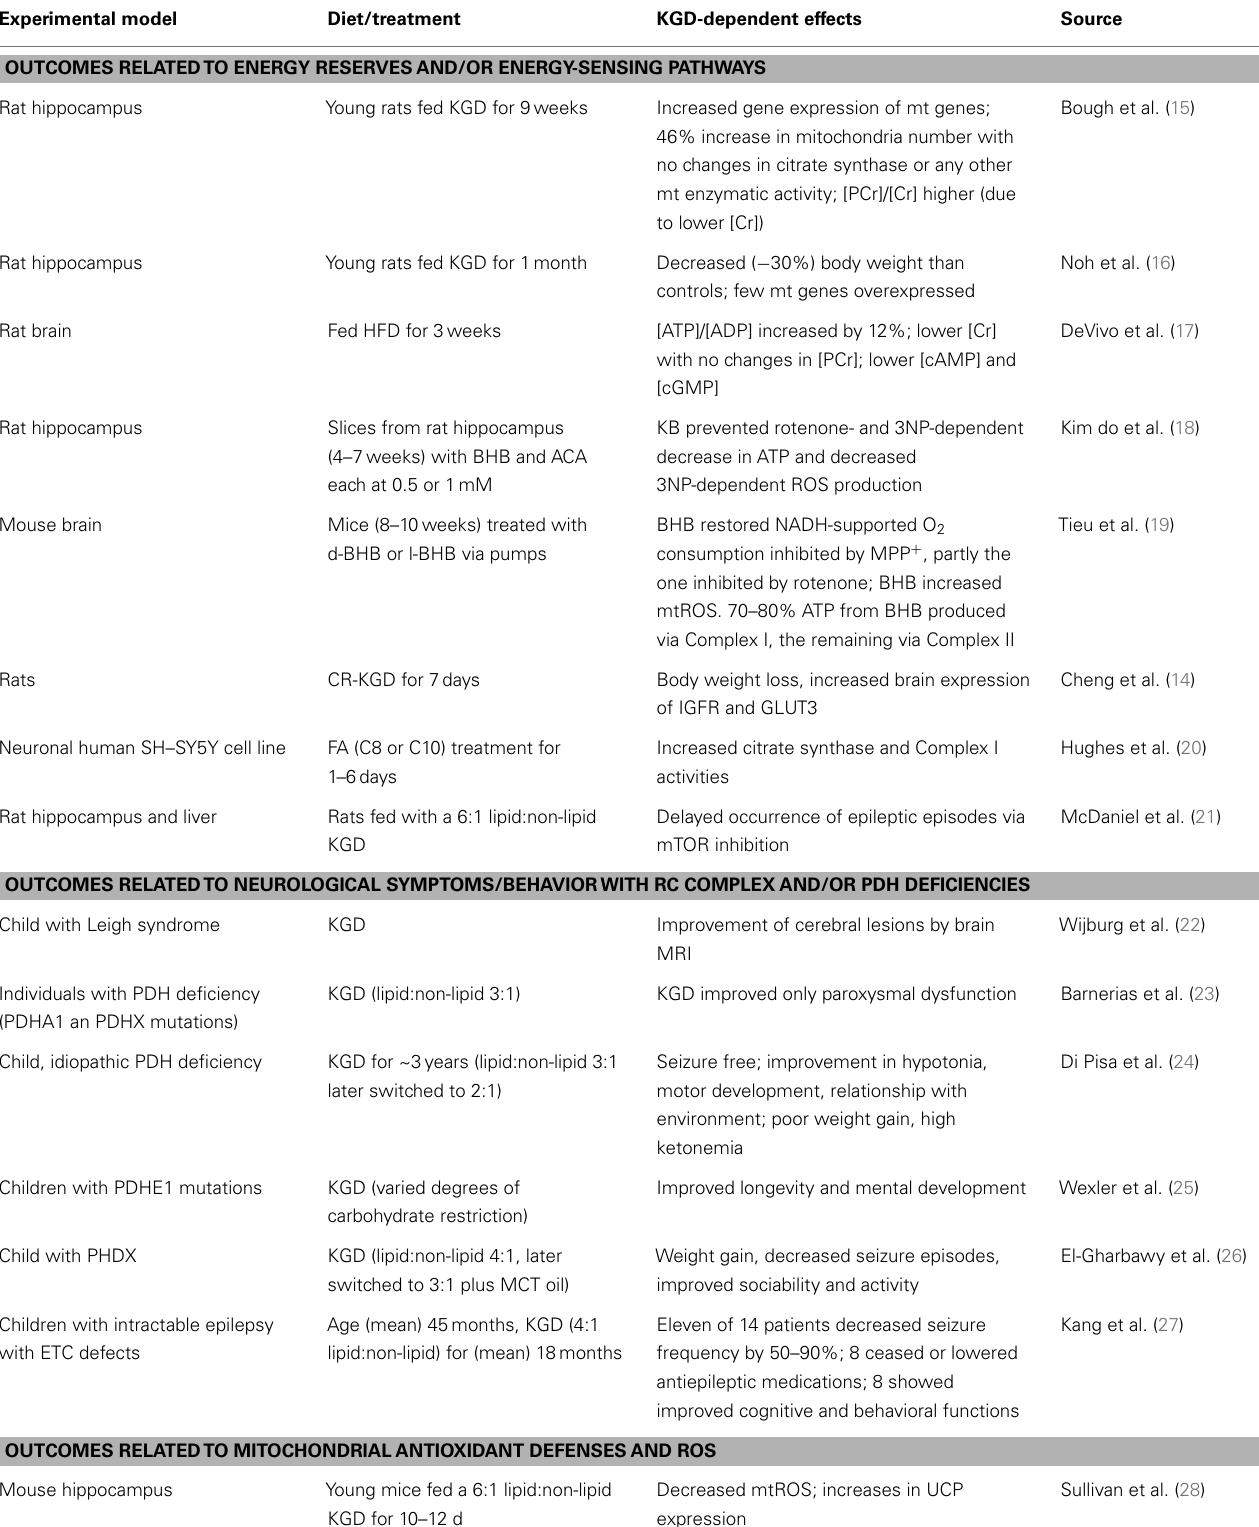
Table 1 | Examples extracted from the literature on effects of KGD on mitochondrial function with the potential to benefitASD symptoms . Experimental